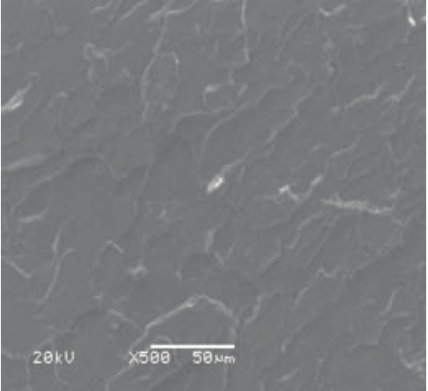
Figure 2: SEM graphs of fracture surfaces of tensile samples.